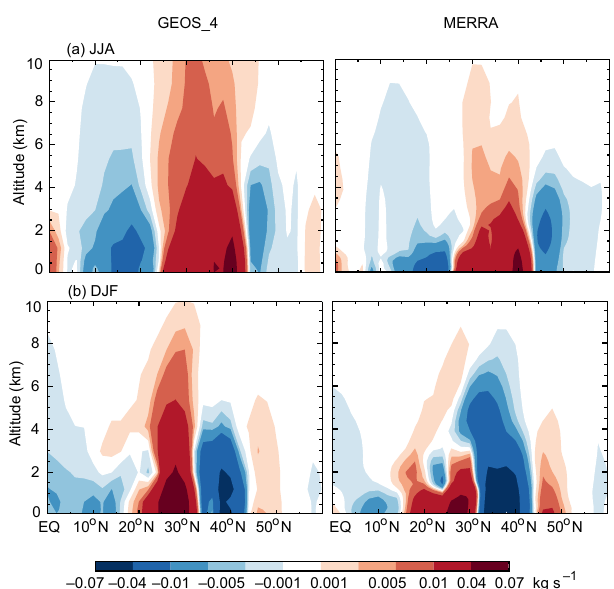
Figure 7. (a) Differences in simulated upward mass flux of JJA BC (kgs − 1 ) between the 5 weakest and 5 strongest EASM years dur- ing 1986–2006. Plots are averaged over a longitude range of 110– 125 ◦ E from model simulations VMETG4 (left) and VMET (right). (b) Same as panel (a) , but for differences in DJF between the 5 weakest and 5 strongest EAWM